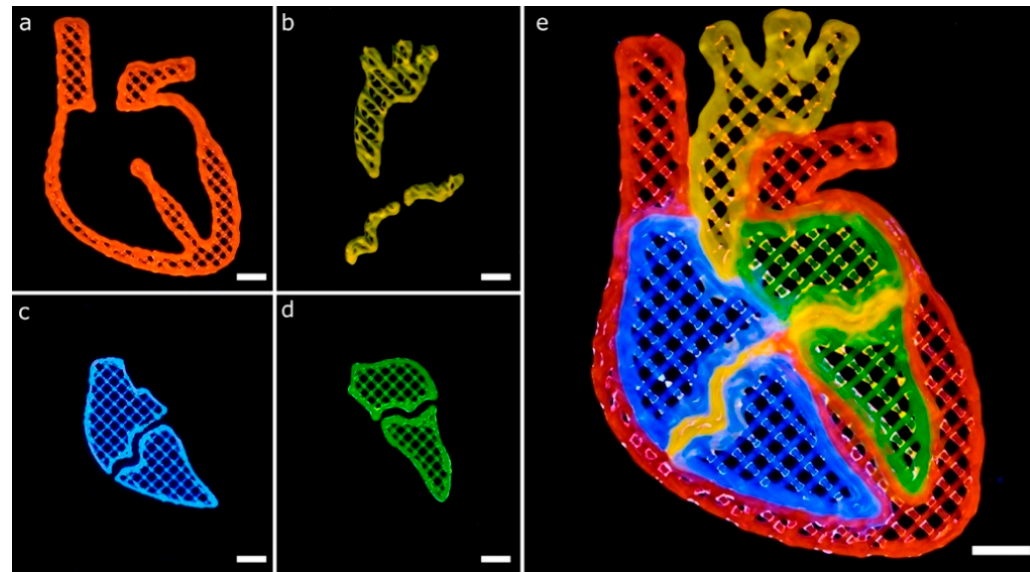
Figure 13. Complex multi-material printing of model that represents a human heart section. The model is composed of heterogeneous bioinks to demonstrate the multi-material capabilities of our system. ( a – d ) printing of the main parts of the heart section separately; ( e ) combination of the multiple parts using the four bioinks in a complex structure; scale bars: 5 mm.